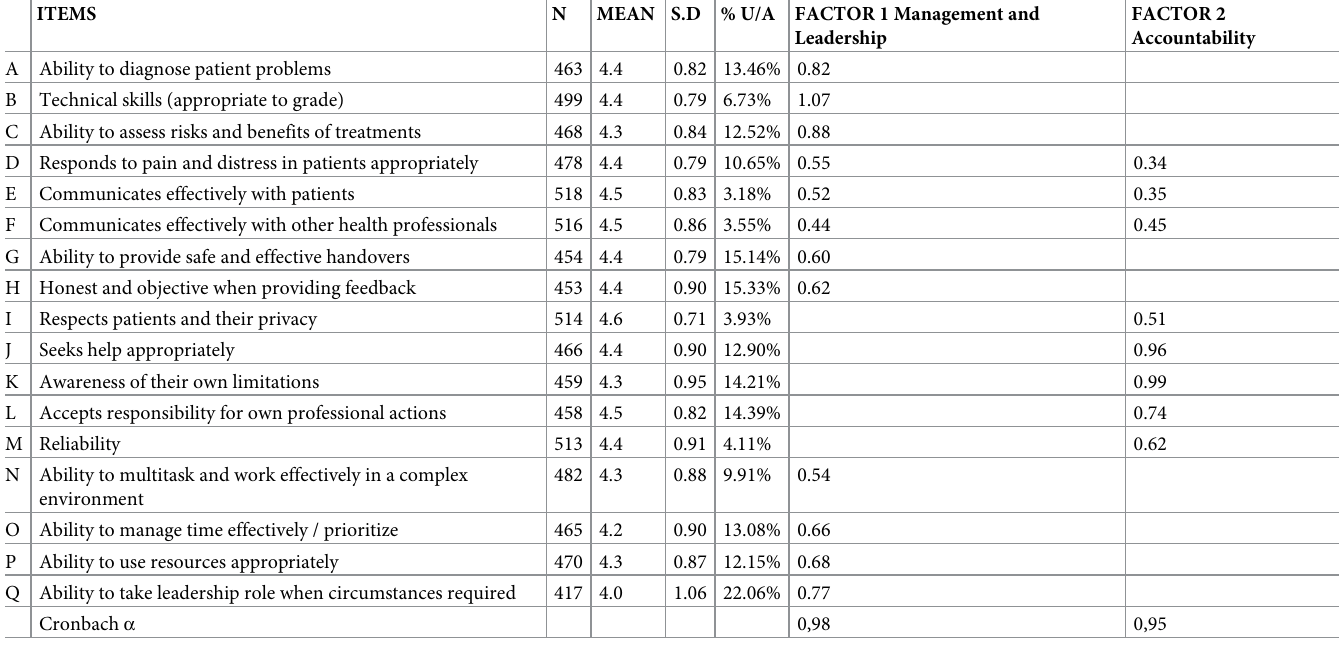
Table 2. Details about questions, response rate and unable to assess rate, factor analysis and Cronbach α scores for